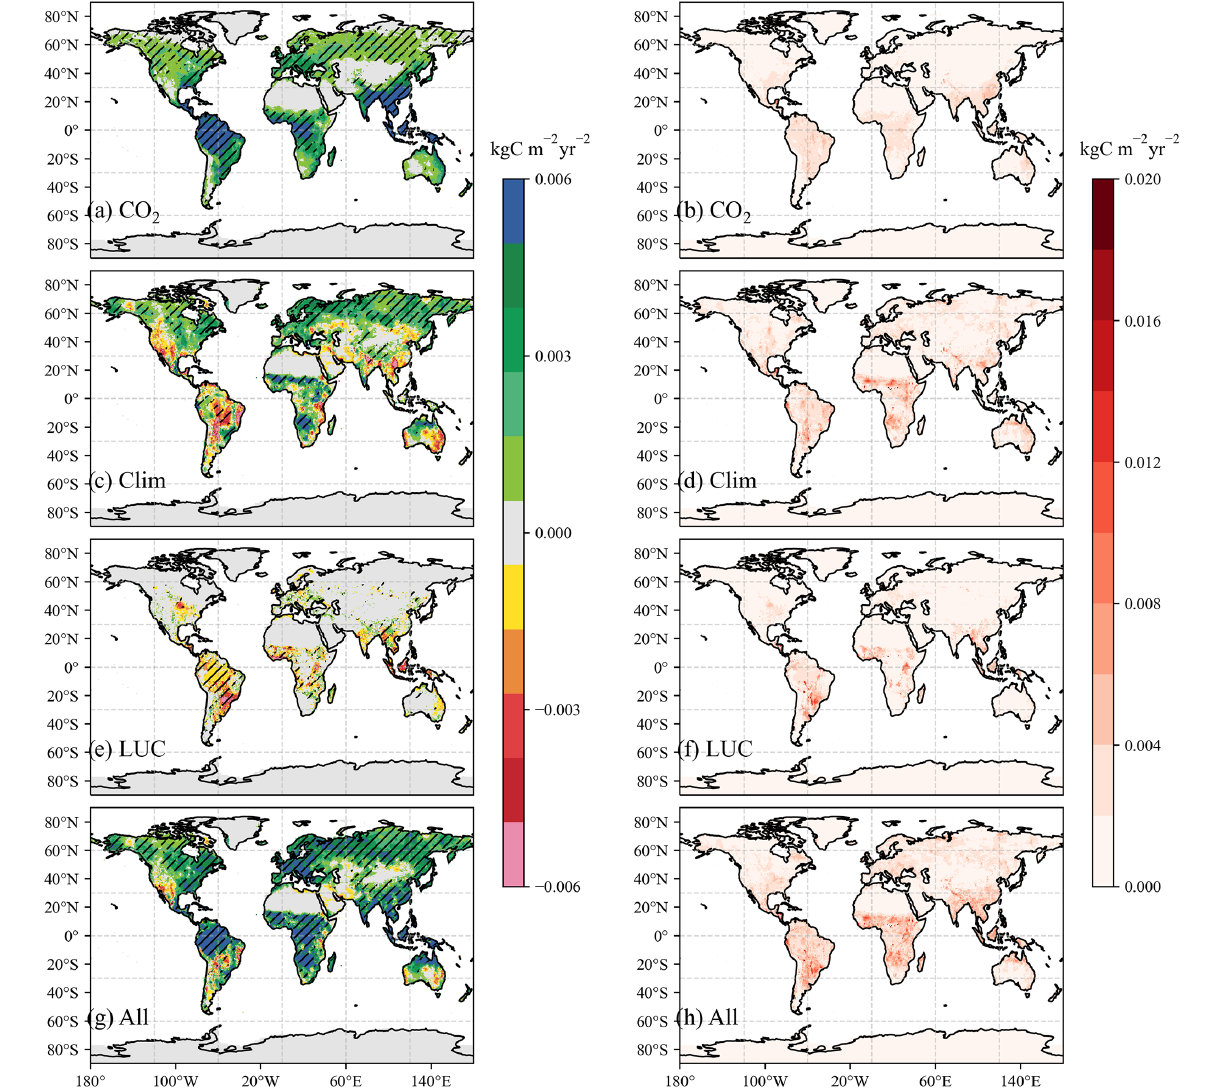
Figure 5. The spatial distribution patterns and the inter-model spreads of GPP trends from the DGVM ensemble. ( a–b ) GPP trends and spreads due to the CO 2 fertilization effect; ( c–d ) GPP trends and spreads due to climate change; ( e–f ) GPP trends and spreads owing to LUC; ( g–h ) GPP trends and spreads from the combined effects of all drivers (S3). Striped areas indicate that the trend is significant with p < 0 . 05 following the non-parametric Mann–Kendall trend